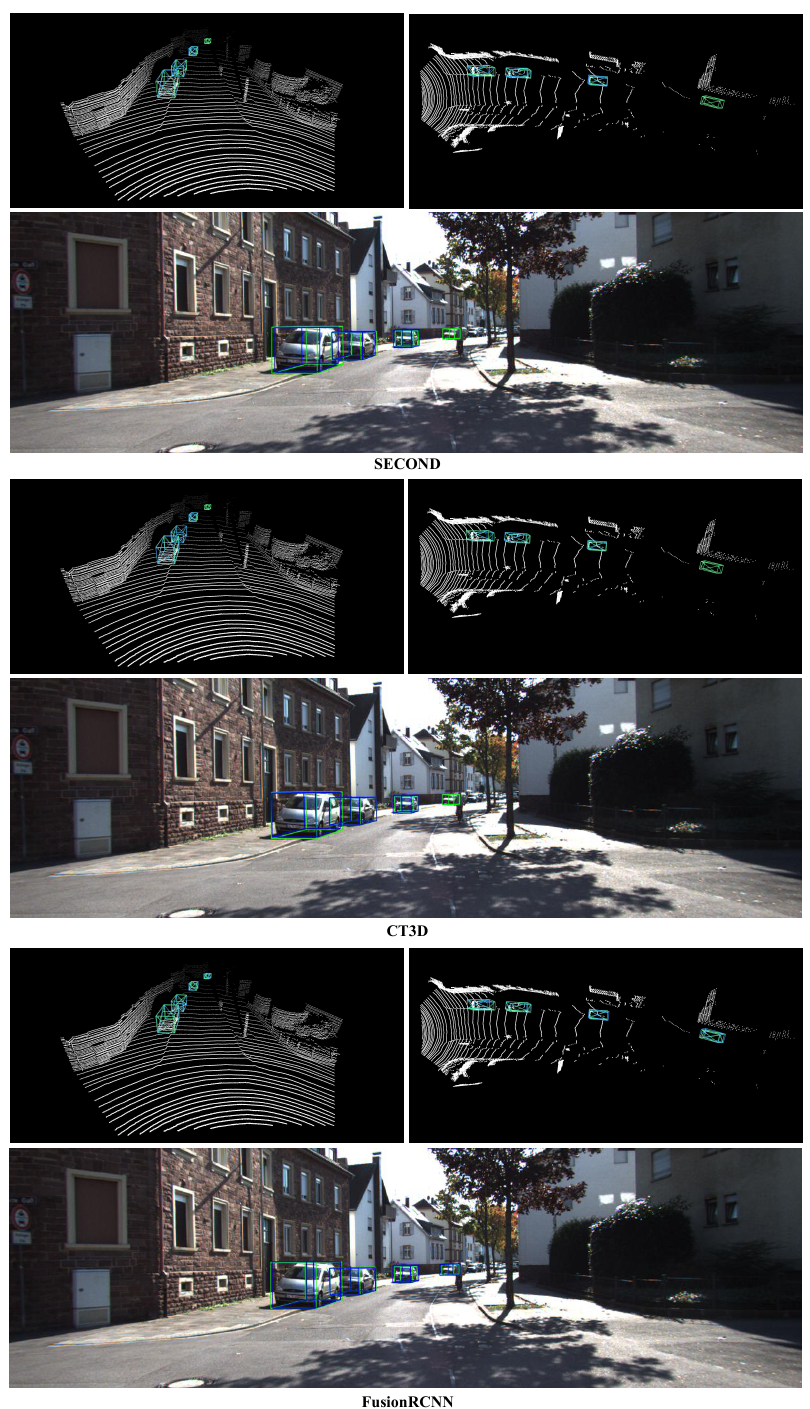
Figure 5. Qualitative comparison between LiDAR-based two-stage detector (CT3D) and our FusionR- CNN on the KITTI Dataset. Green boxes and Blue boxes are ground-truth and predictions, respectively. Our FusionRCNN performs better than CT3D with only LiDAR input in long-range